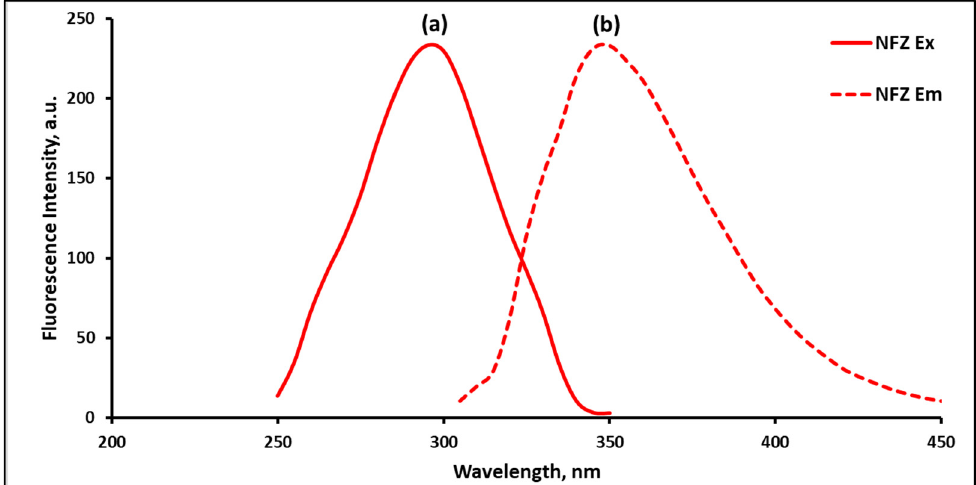
Figure 5. Excitation and emission spectra of NFZ extracted from human serum samples using SALLE upon its reduction with potassium borohyfride, where (a) and (b) represent reduced NFZ excitation and emission spectra using emission setting of 350 nm and excitation setting of 295 nm, respectively. Table 6. The recovery of naftazone from spiked serum samples using SALLE. Table 5. Accuracy and precision data for of naftazone determination in spiked serum samples. Spiked Level